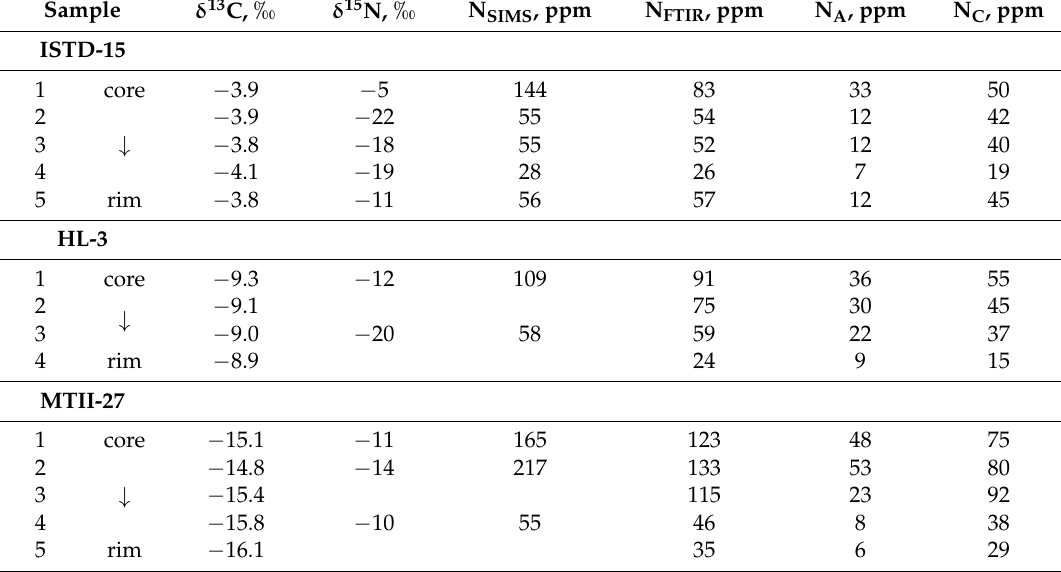
Table 1. Isotopic compositions of carbon ( δ 13 C) and nitrogen ( δ 15 N) and nitrogen concentrations (N) in cuboid diamonds from alluvial placers in the northeastern Siberian platform. Also indicated are the nitrogen concentrations as measured by SIMS and